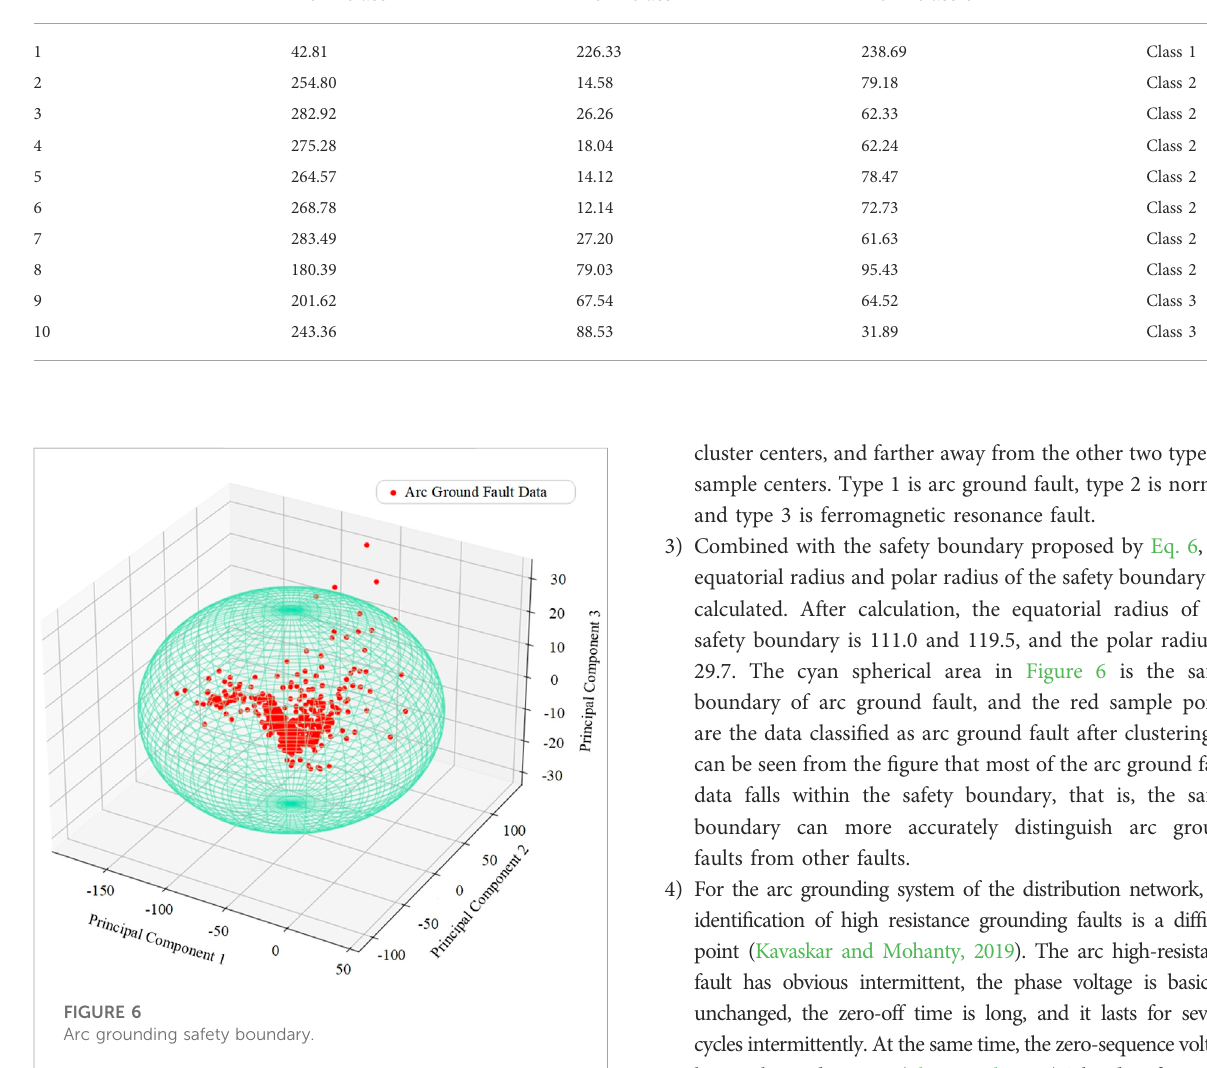
TABLE 6 Distance table between test sample and cluster center Test data